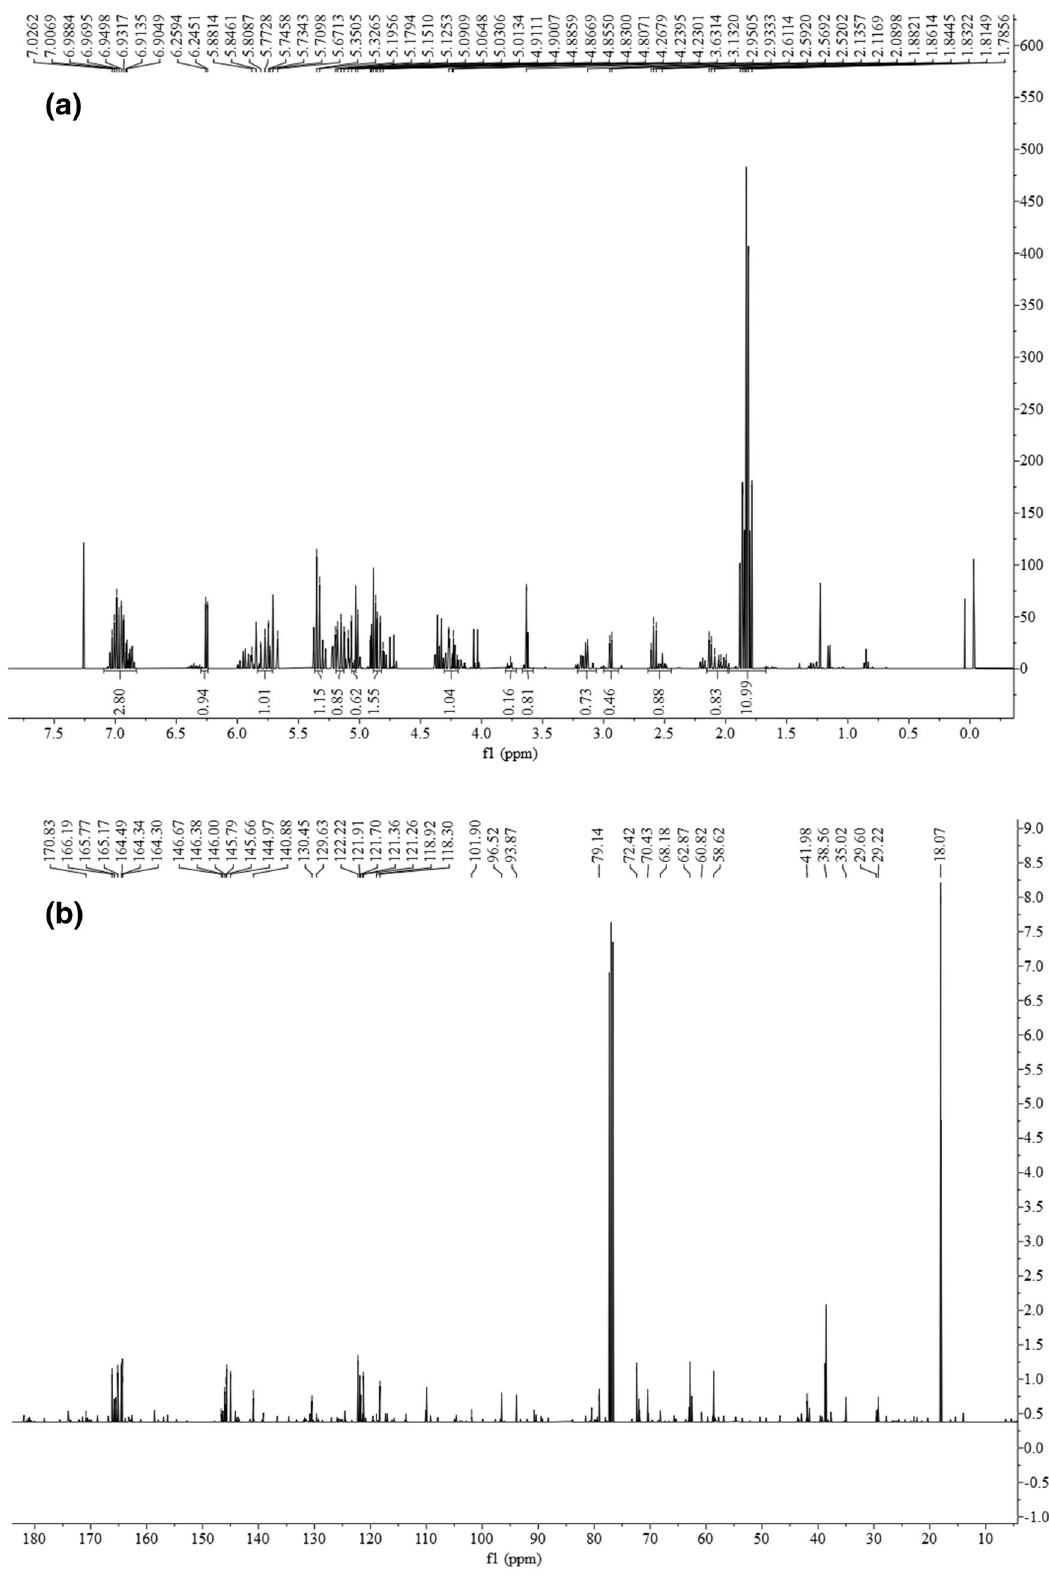
Figure 5. NMR spectra of CC-6. ( a ) 1 H NMR spectrum of CC-6; ( b ) 13 C NMR spectrum of